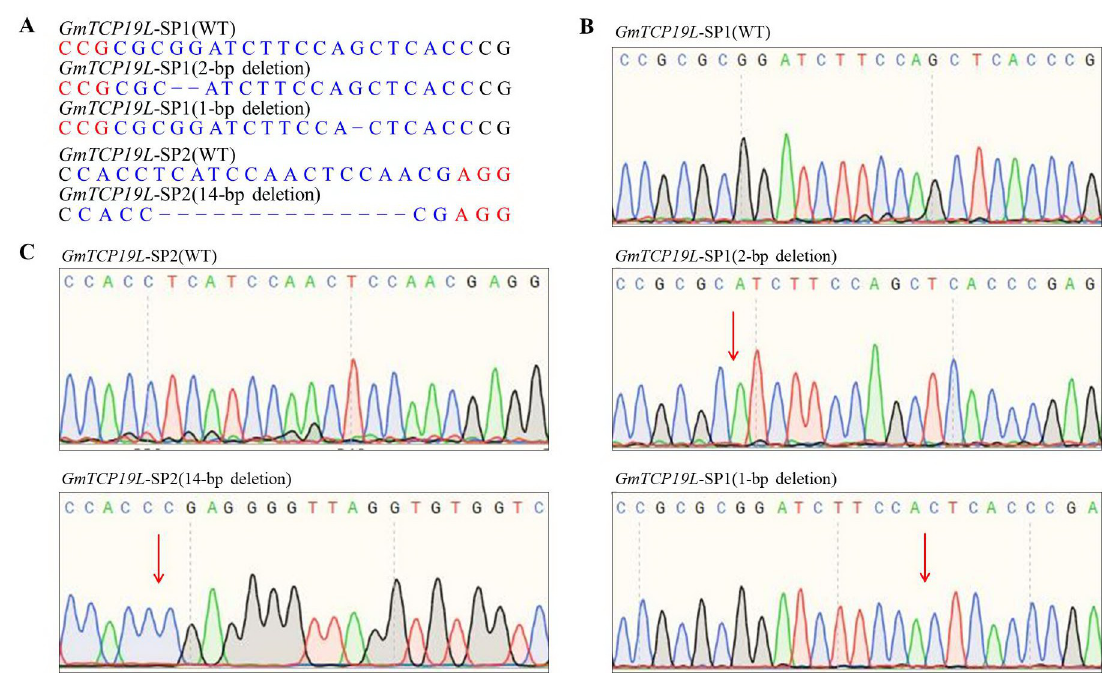
Fig 2. Homozygous targeted mutagenesis of GmTCP19L induced by CRISPR/Cas9 in the T1 generation. (A) Sequences of WT and representative mutation types induced at target sites GmTCP19L -SP1 and GmTCP19L -SP2. Dashes, deletions. (B) and (C) Sequence peaks of WT and representative mutation types at target sites GmTCP19L -SP1 and GmTCP19L -SP2. The red arrowheads indicate the location of mutations. WT, wild-type soybean plant.